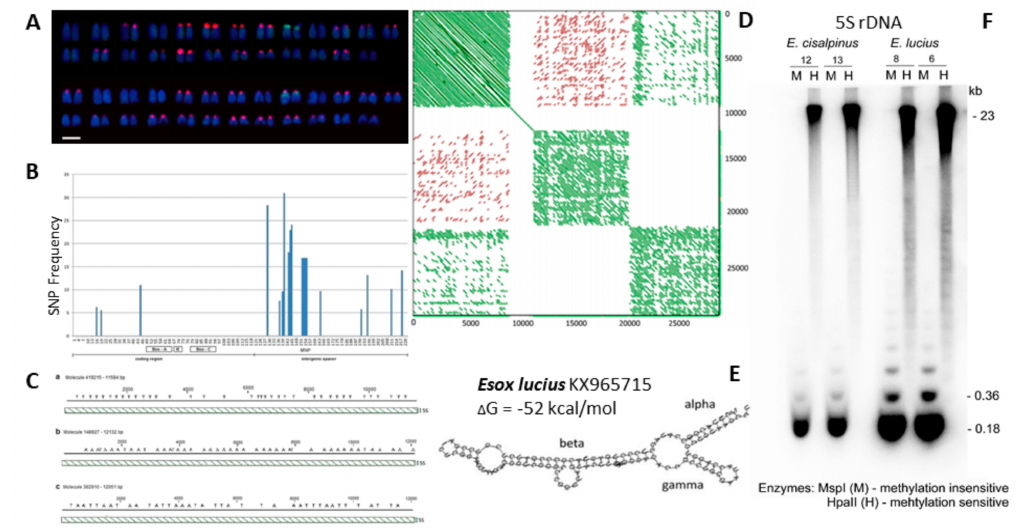
Figure 3. Summary of an integrative cytogenomic study on the rDNAome in European pikes ( Esox lucius and E. cisalpinus ). ( A ) Fluorescence in situ hybridization (FISH) with 5S rDNA (red) and 45S rDNA (green); ( B ) Distribution of single-nucleotide polymorphism (SNPs) along the E. lucius 5S rDNA unit obtained from Illumina reads showing absence of SNPs in the internal controlling region composed of Box-A, IE and Box-C elements; ( C ) Distribution of variants in intergenic spacer regions (IGS) in three PacBio reads (a–c). Slanted lines indicate tandemly arranged units visualized through the alignment of reads ( x -axis) with a 5S gene ( y -axis); ( D ) Higher-order organization of 5S rDNA arrays in E. lucius . Self-to-self comparison of long PacBio molecules representing three groups; ( E ) 5S rRNA domain reconstruction of E. lucius indicating its potential functionality; ( F ) Methylation analysis of 5S rDNA by the methylation-sensitive HpaII (H) restriction enzyme and its methylation-insensitive MspI (M) isoschizomere. Reproduced from